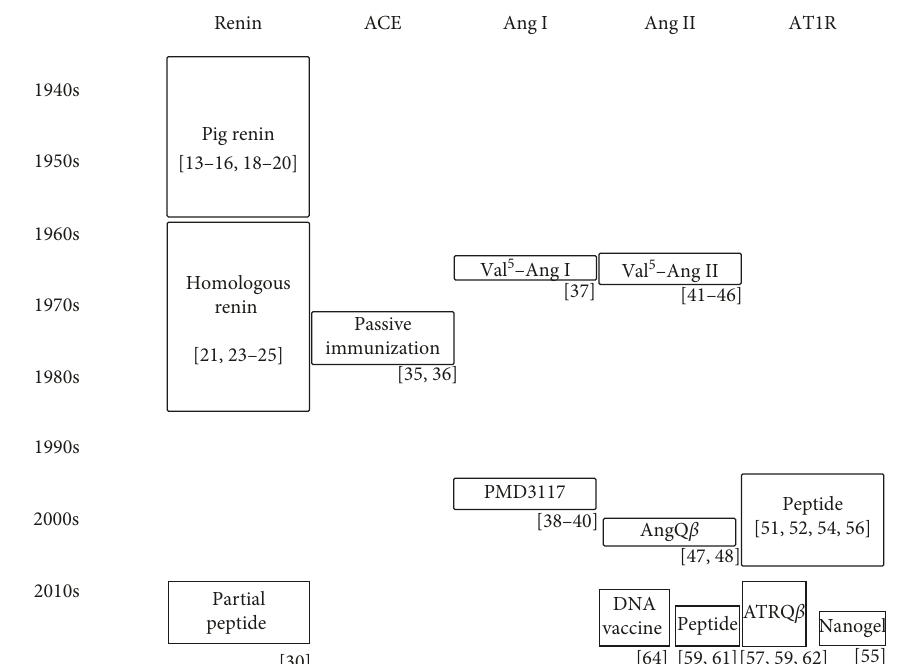
Figure 1: Historical development of hypertension vaccines. ACE: angiotensin converting enzyme; Ang: angiotensin; AT1R: angiotensin II type 1